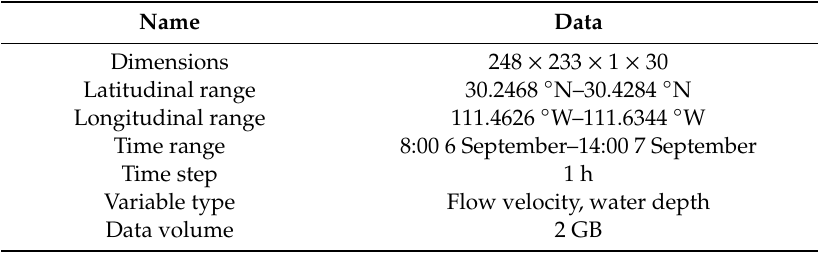
Figure 2. Cross-sectional data distribution. Table 1. Summary of the river flood data.